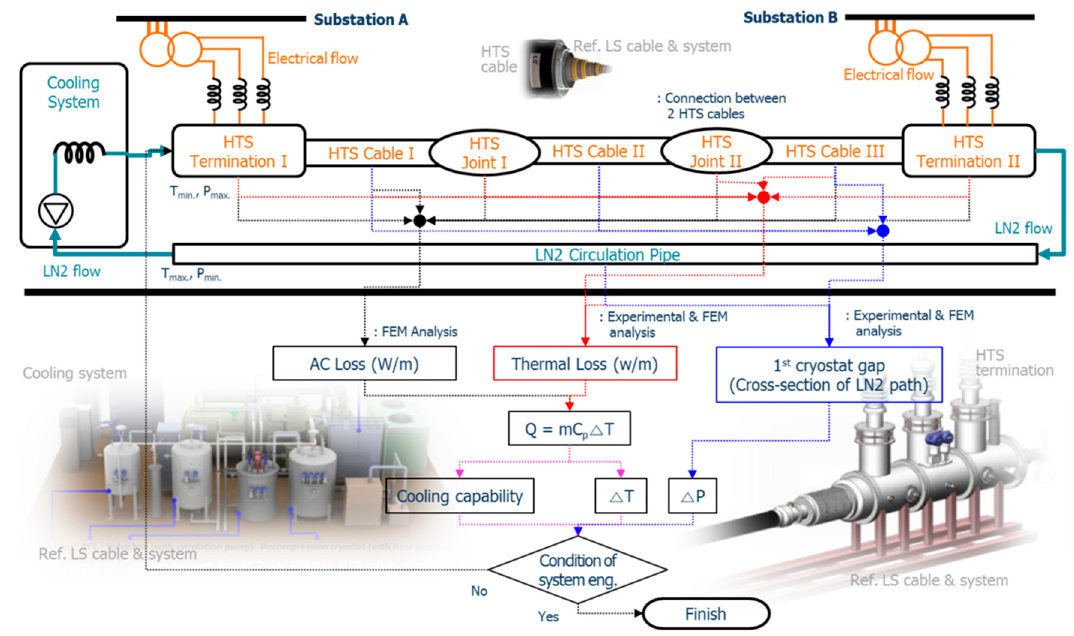
Figure 1. One-circuit configuration of the HTS cable system (about 1 km).